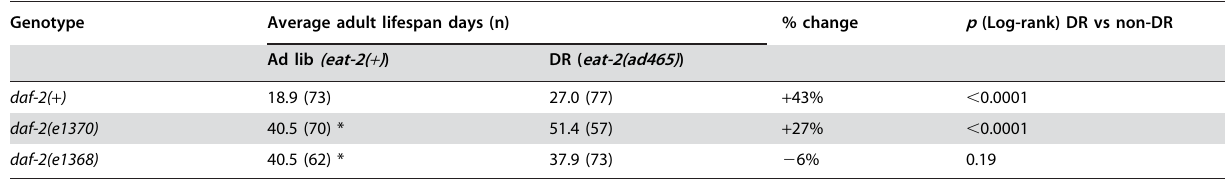
Table 1. DR, imposed by the eat-2(ad465) mutation, extended adult lifespan of daf-2(e1370) , but not daf-2(e1368) . .. ... .... ... ... .... ... ... .... ... ... .... ... ... .... ... ... .... ... ... .... ... ... .... ... ... .... ... ... .... ... ... .... ... ... .... ... ... .... ... ... .... ... ... . Genotype